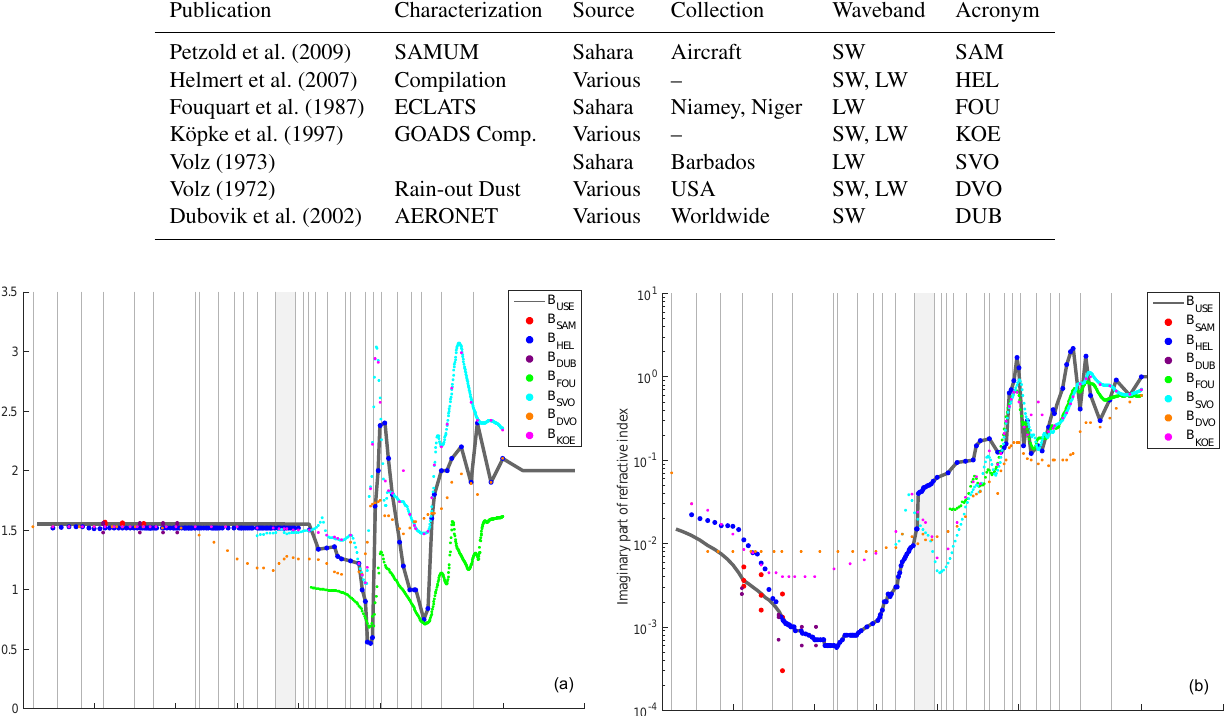
Figure 1. Real (a) and imaginary (b) part of refractive indices according to studies listed in Table 4 and used in ICON-ART ( B USE ). The borders of the RRTM radiation scheme wavebands are adumbrated as light grey lines in the background. The filled grey band represents the waveband present both in the longwave and shortwave part of the